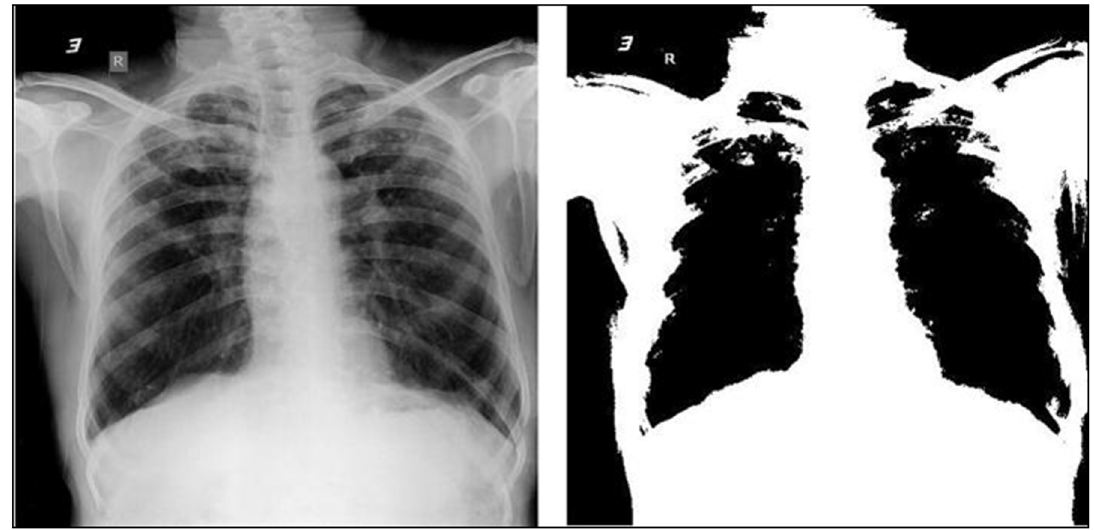
Figure 4. X-ray image before and after Euler-based segmentation. The Euler-based segmented image provides initial contour for Chan-Vese segmentation.